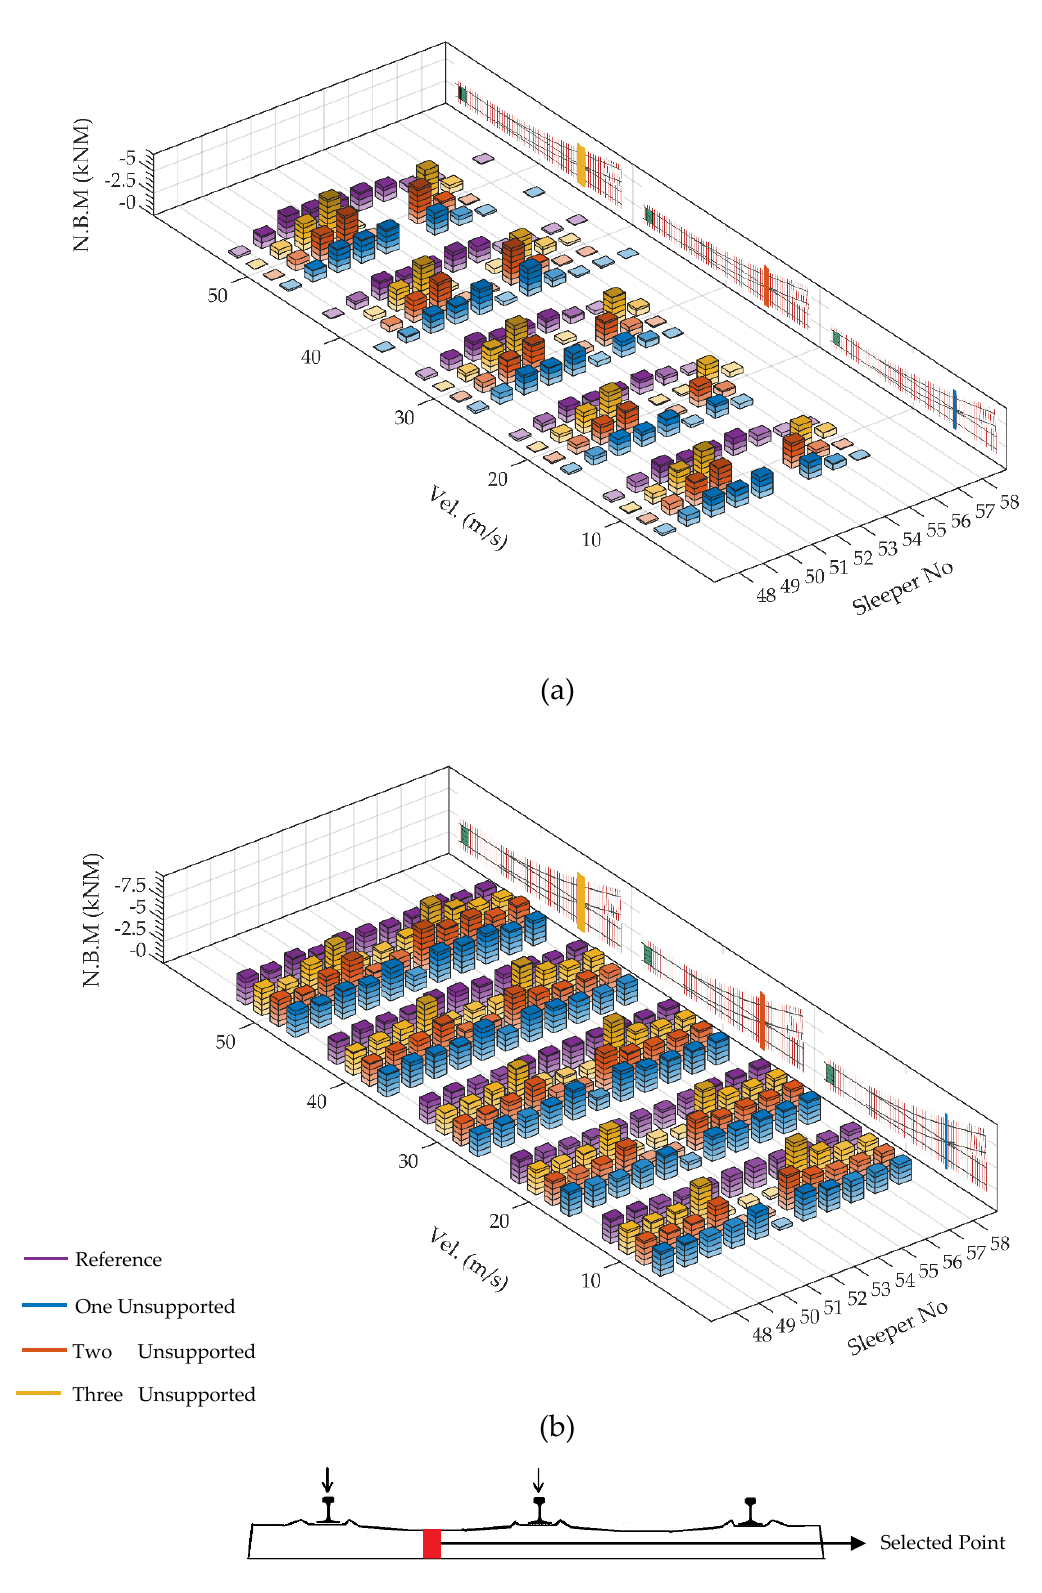
Figure 19. The distribution of negative bending moments over the bearers when unsupported bearers exist under crossing nose: (a) at particular time when the front wheel is on the bearer with number 53; (b) when maximum occurs at each bearer.